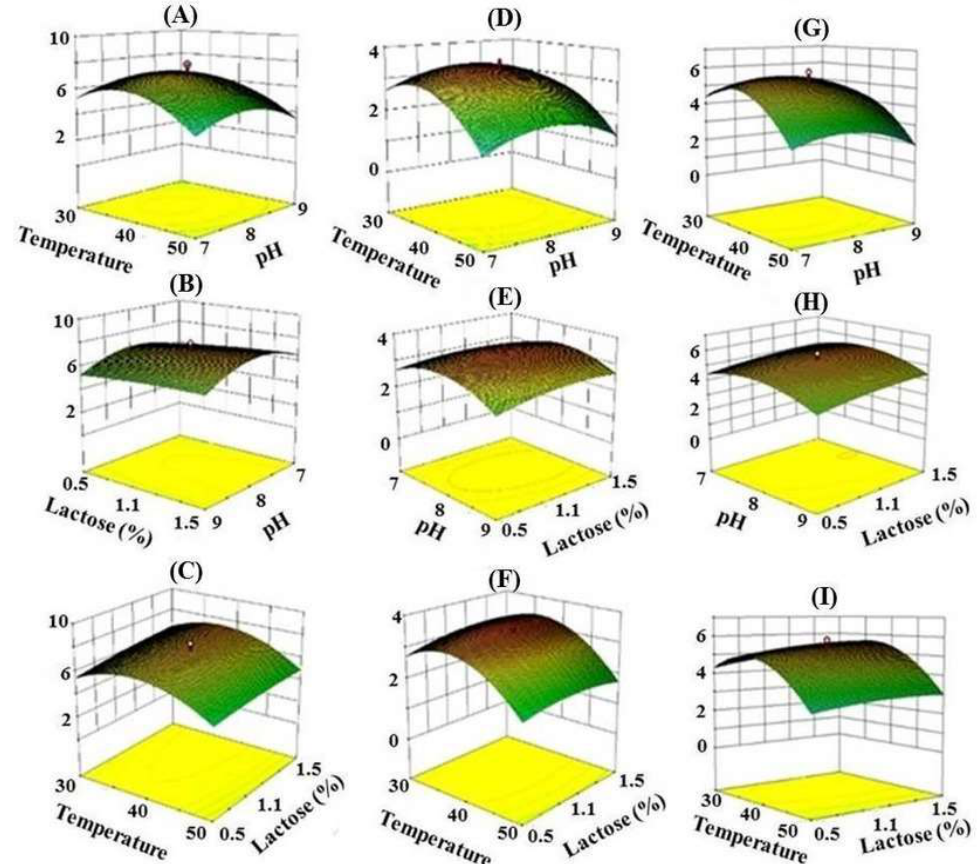
Figure 8. Three dimensional response surface graphs for ( A – C ) amylase activity; ( D – F ) agarase ac- tivity ( G – I ) xylanase